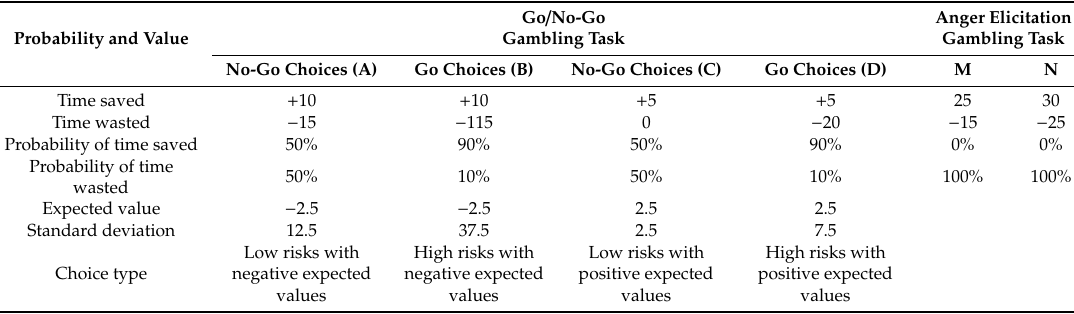
Table 1. Probability and value of experiment task